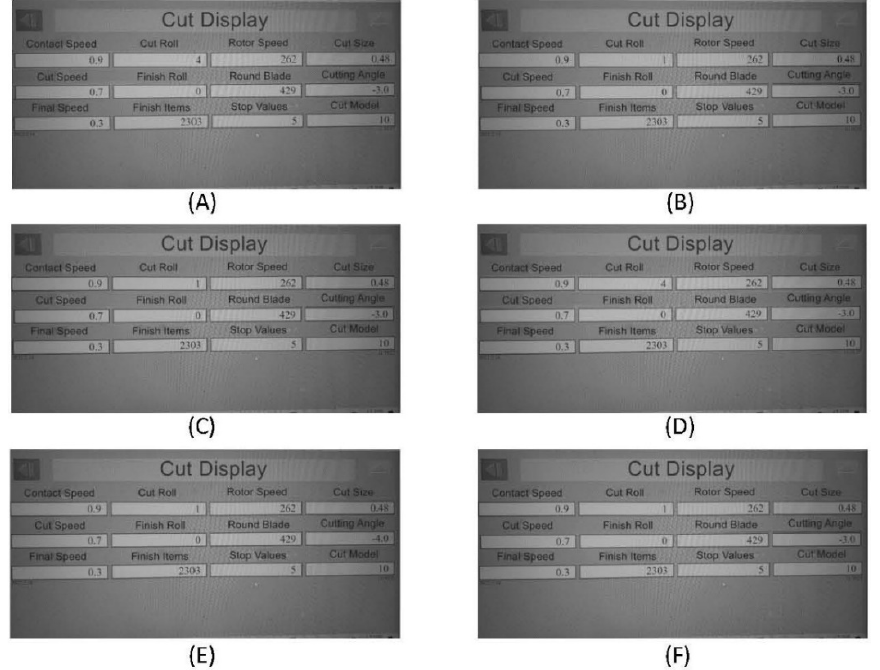
Figure 9. The result of scene changes in six continuous frames ( A )frame 1; ( B ) frame 2; ( C ) frame 3; ( D ) frame 4; ( E ) frame 5; ( F ) frame 6.